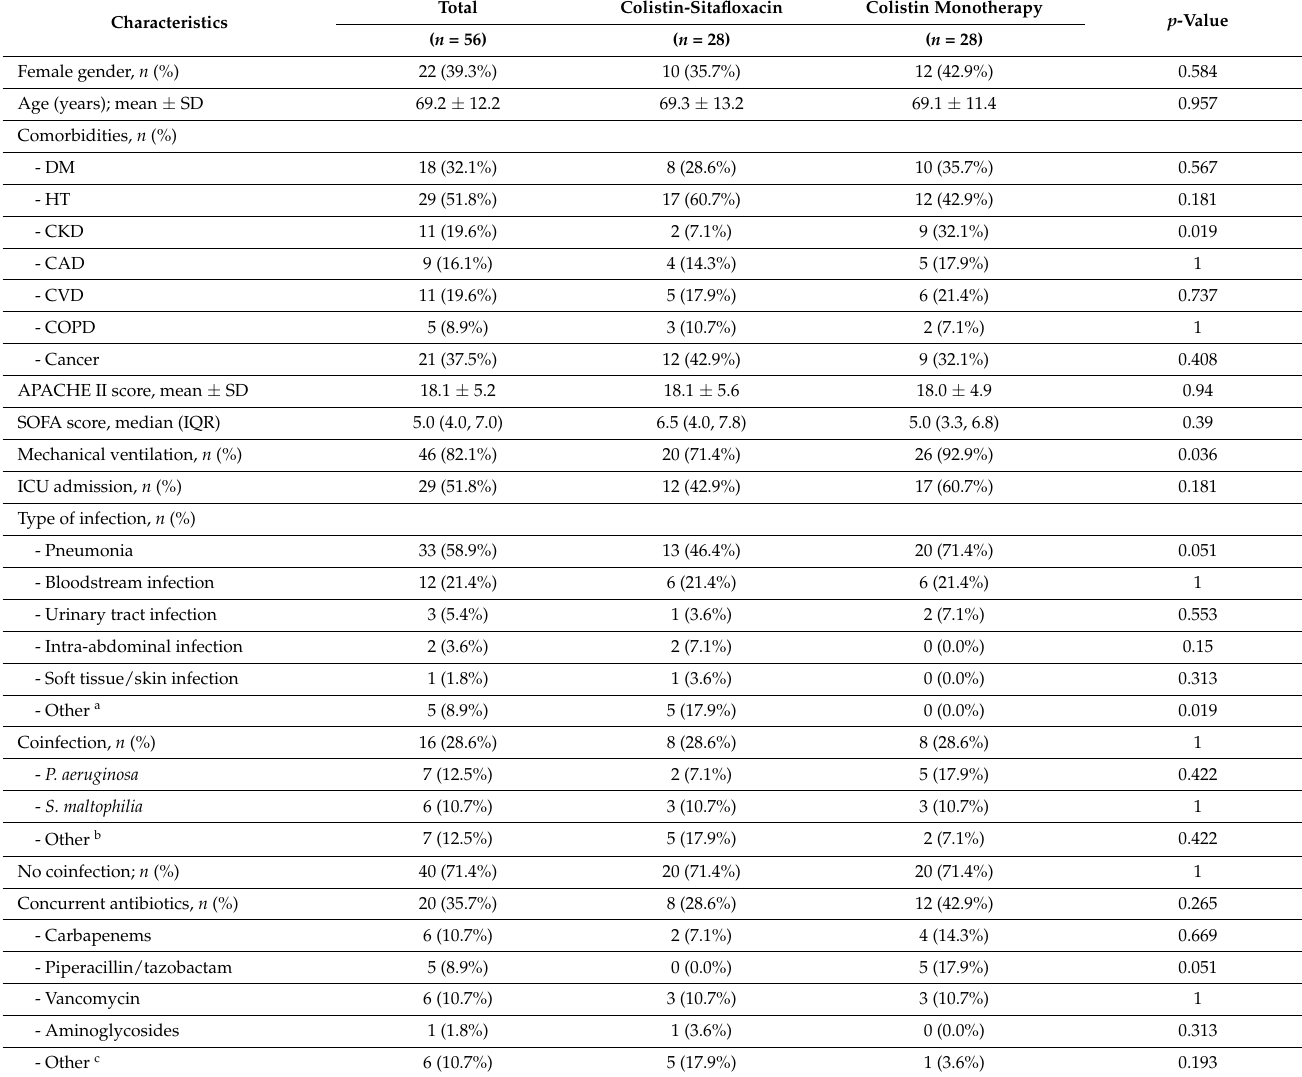
Table 1. The baseline characteristics of all study patients and compared between the combination group and the monotherapy